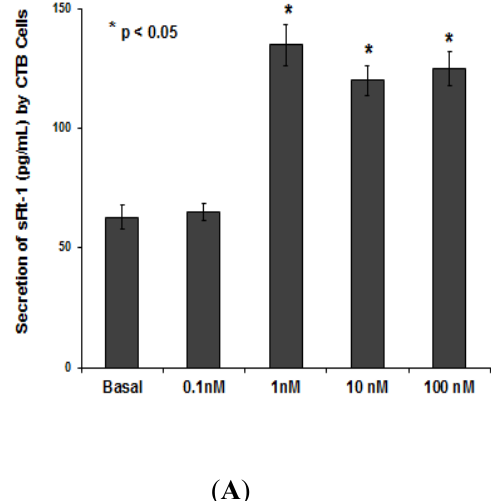
Figure 3. CTB cells were treated with different concentrations of PNTTU and the levels of ( A ) sFlt-1 and ( B ) VEGF were measured in the cell culture media by ELISA. PNTTU significantly ( * p < 0.05) upregulated the secretion of sFlt-1 and downregulated the secretion of VEGF by CTB cells. The results are presented as the mean ± SEM (n = 6, four replicates